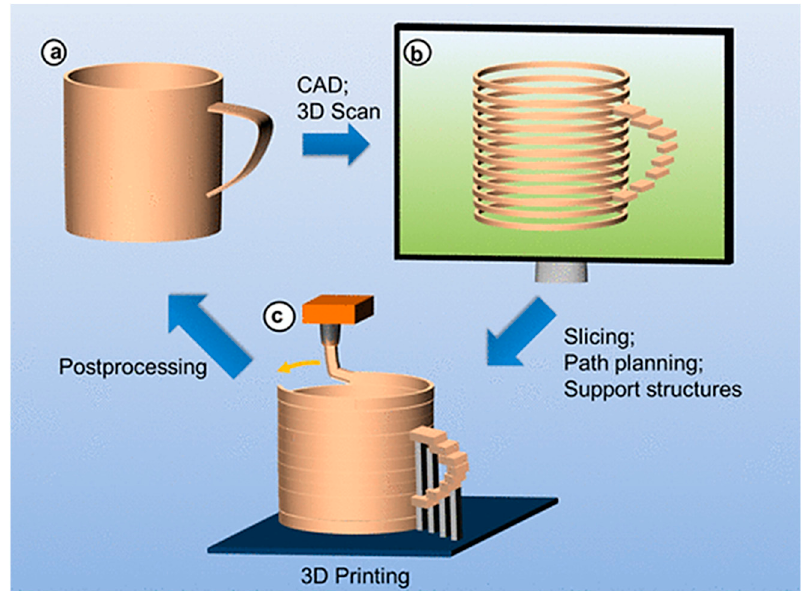
Figure 12. Basic principle of 3D printing ( a ) product idea development and the transformation of digital data via CAD; ( b ) preprocessing of CAD model into virtual layered data and later its transfer to 3D printer; and ( c ) 3D printing of final product after postprocessing [119]. Reproduced with permission from ACS.